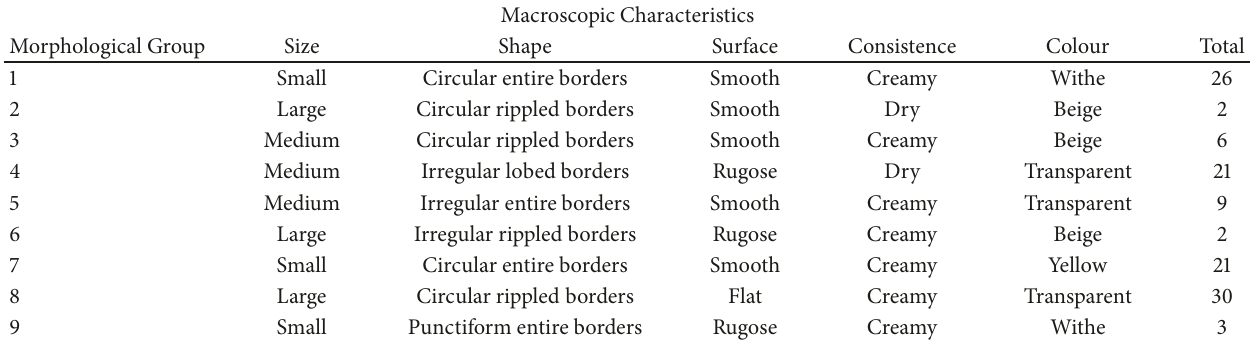
Table 5: Macroscopic morphological characteristics of isolated